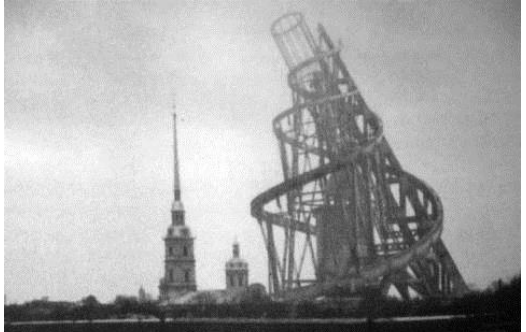
Fig. 29 The monument to the third International (Tatlin)